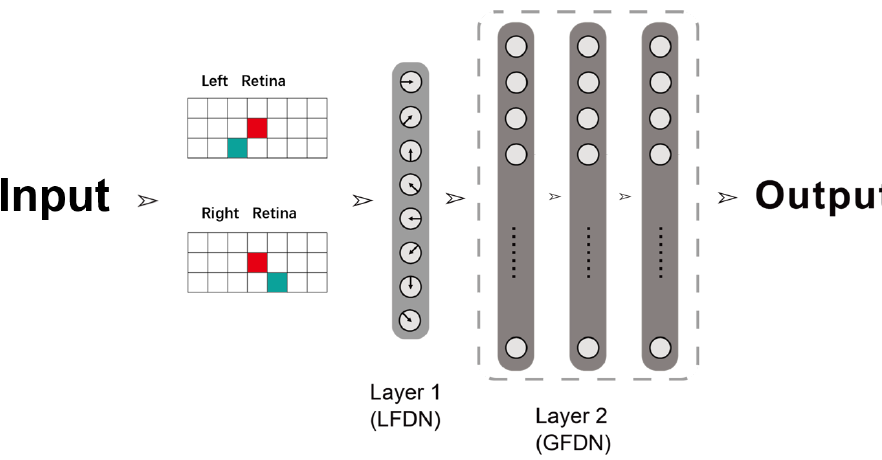
Figure 7. Structure of Artificial visual system (AVS). In the input module, visual information in the receptor of eyes is projected in the retinas of left and right eyes. The information from left and right retina is processed and delivered to the layer 1—local feature detective neurons (LFDN) layer. Neurons in layer 1 are responsible for the detection of the motion direction, corresponding to the cortical neurons. Then, the information is transmitted to the second layer—global feature detective neuron (GFDN) layers and more complex features (like global motion direction) are invesgated.